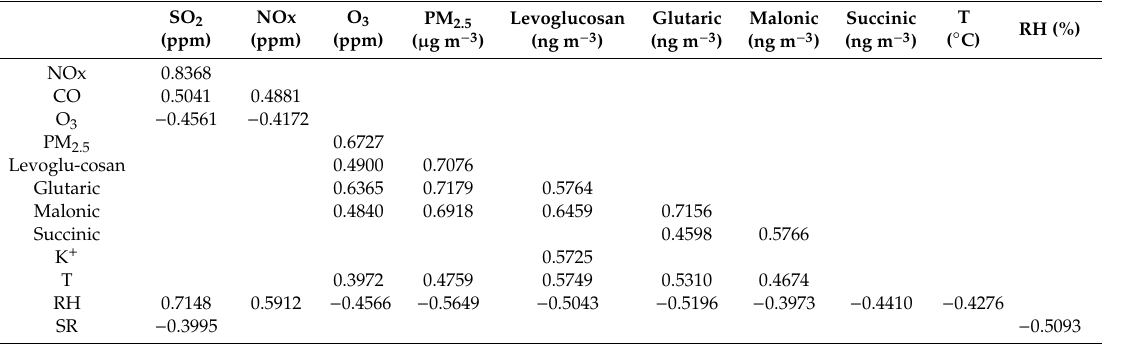
Table 7. Correlations between meteorological parameters, criteria air pollutants and organic pollutants evaluated in Cuernavaca (Site 1) in 2016.